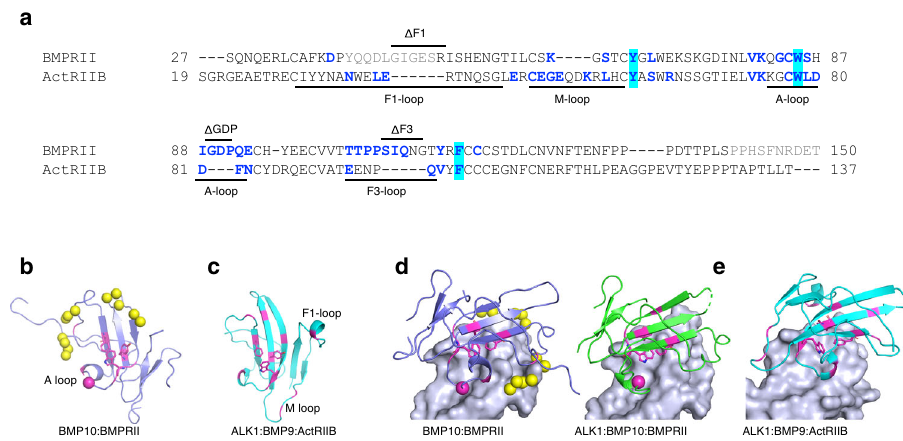
Fig. 5 Comparison of BMP10 binding site on BMPRII with BMP9 site on ActRIIB. a Sequence alignment of BMPRII ECD and ActRIIB ECD. Residues at the binding interface with BMP10 or BMP9 are shown in blue. Residues that are not modelled in the BMPRII structure are shown in grey. Hydrophobic triad residues are highlighted in cyan. Positions of the four loops are highlighted below the sequence. Lines above the sequence highlight the residues deleted in the mutagenesis studies. Δ F1(F3) = deletion of fi nger 1 ( fi nger 3) residues; Δ GDP = deletion of residue Gly, Asp and Pro. b , c BMP10-binding site on BMPRII ( b , light purple) and BMP9-binding site on ActRIIB ( c , cyan). Residues making direct interactions with BMP10 or BMP9 are coloured in magenta, with hydrophobic triad residues shown in sticks. BMP10 G89 is highlighted in a magenta sphere. Water molecules that mediate hydrogen bond interactions between BMPRII and BMP10 are shown in yellow spheres. d BMPRII in binary (complex AC, purple cartoon) and ternary (complex AI, green cartoon) complexes on BMP10 surface (pale blue), showing G89 (magenta spheres) docking into a deep pocket on BMP10. e ActRIIB (cyan cartoon) on BMP9 surface (pale blue, from PDB entry 4FAO) does not have A-loop mediated interaction. In d , e , residues making H-bond interactions shown in magenta, and hydrophobic triad shown in magenta